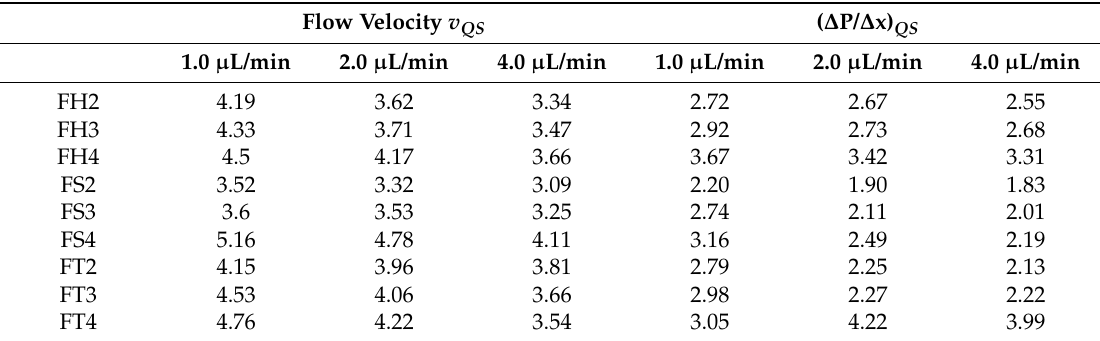
Table 3. Analysis of the decay constants in the first-order response for shallow